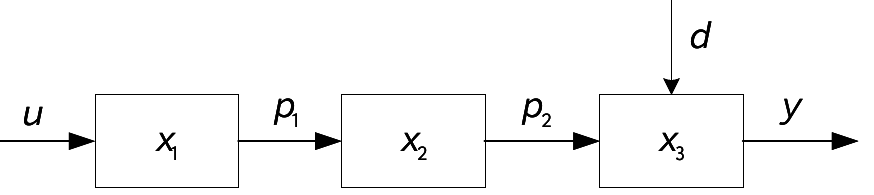
Figure 2. Supply chain system upstream and downstream enterprises inventory production relation- ship